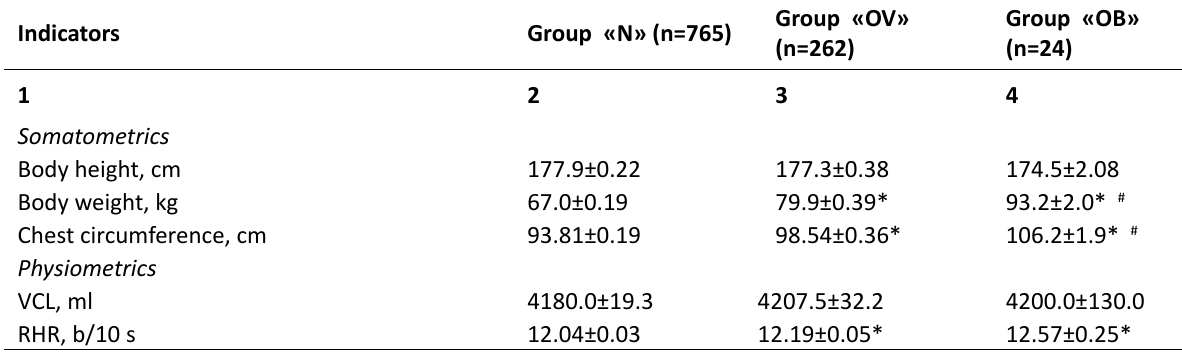
Table 3. The morphofunctional characteristics of males with different means of BMI